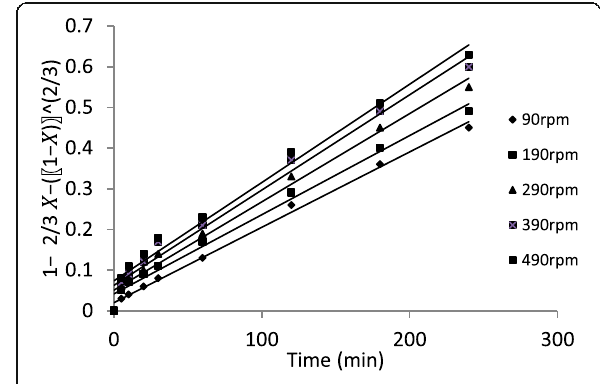
X − ð 1 − X Þ 2 3 versus dissolution time at different Fig. 5 Plot of 1 − 2 3 agitation rates